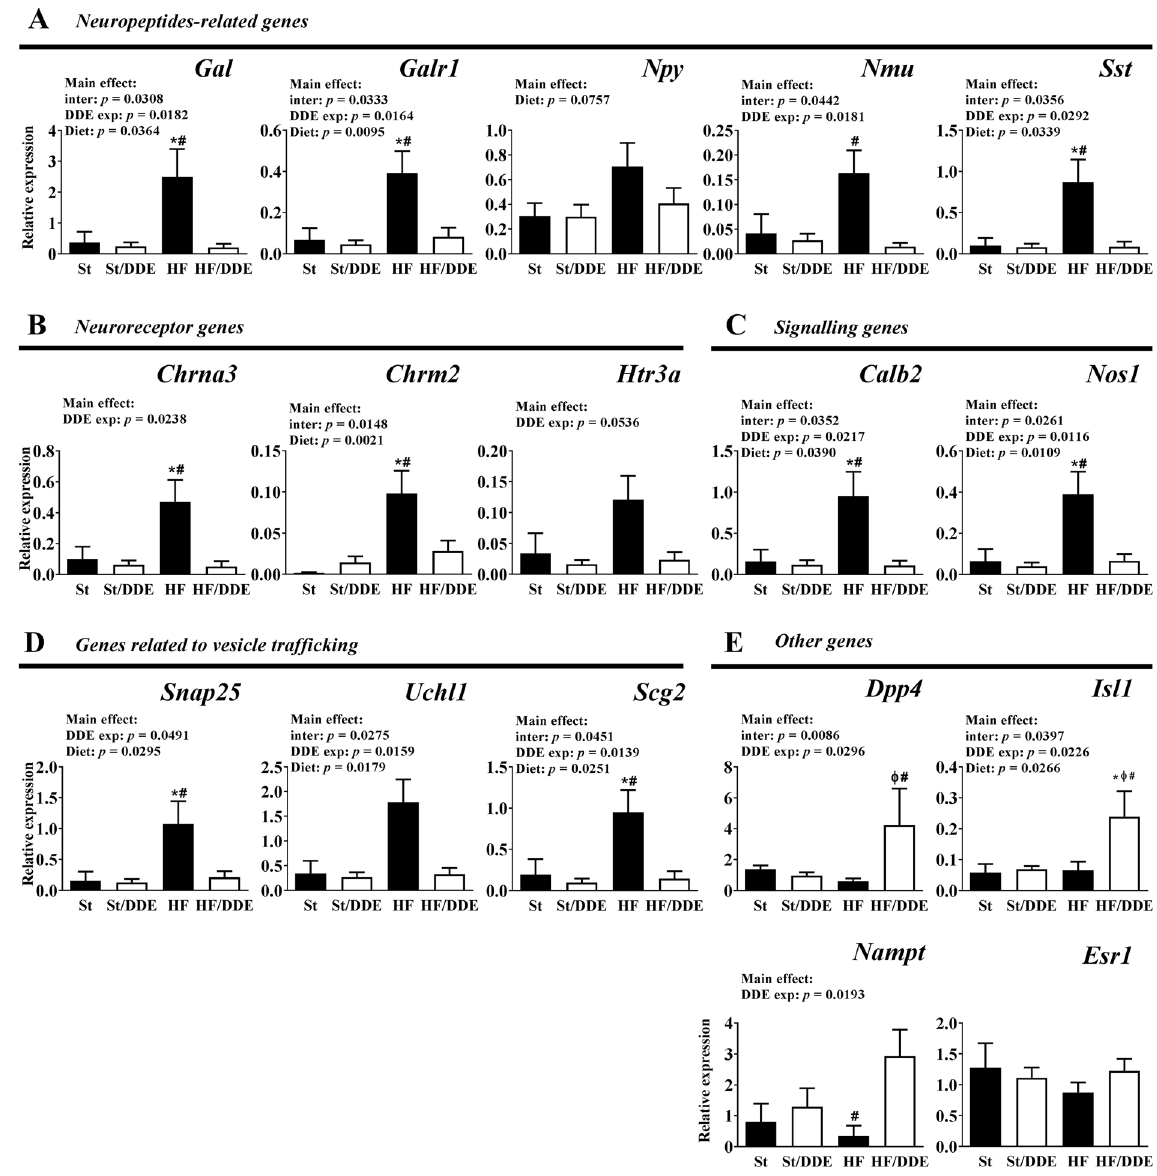
Figure 6. Gene expression analysis by quantitative real-time PCR (qRT-PCR) in visceral adipose tissue. Gene expression normalised to the housekeeping genes ( Hprt , Gusb and Tbp ). Statistical analysis with two-way ANOVA (main effects: diet, p , p ’-DDE exposure and their interaction; p < 0.05), followed by Tukey’s multiple comparison post-hoc test: * p < 0.05 vs St, # p < 0.05 vs HF/DDE and Ø p < 0.05 vs St/DDE. St, standard diet; HF, high fat diet; p , p ’-DDE, p , p